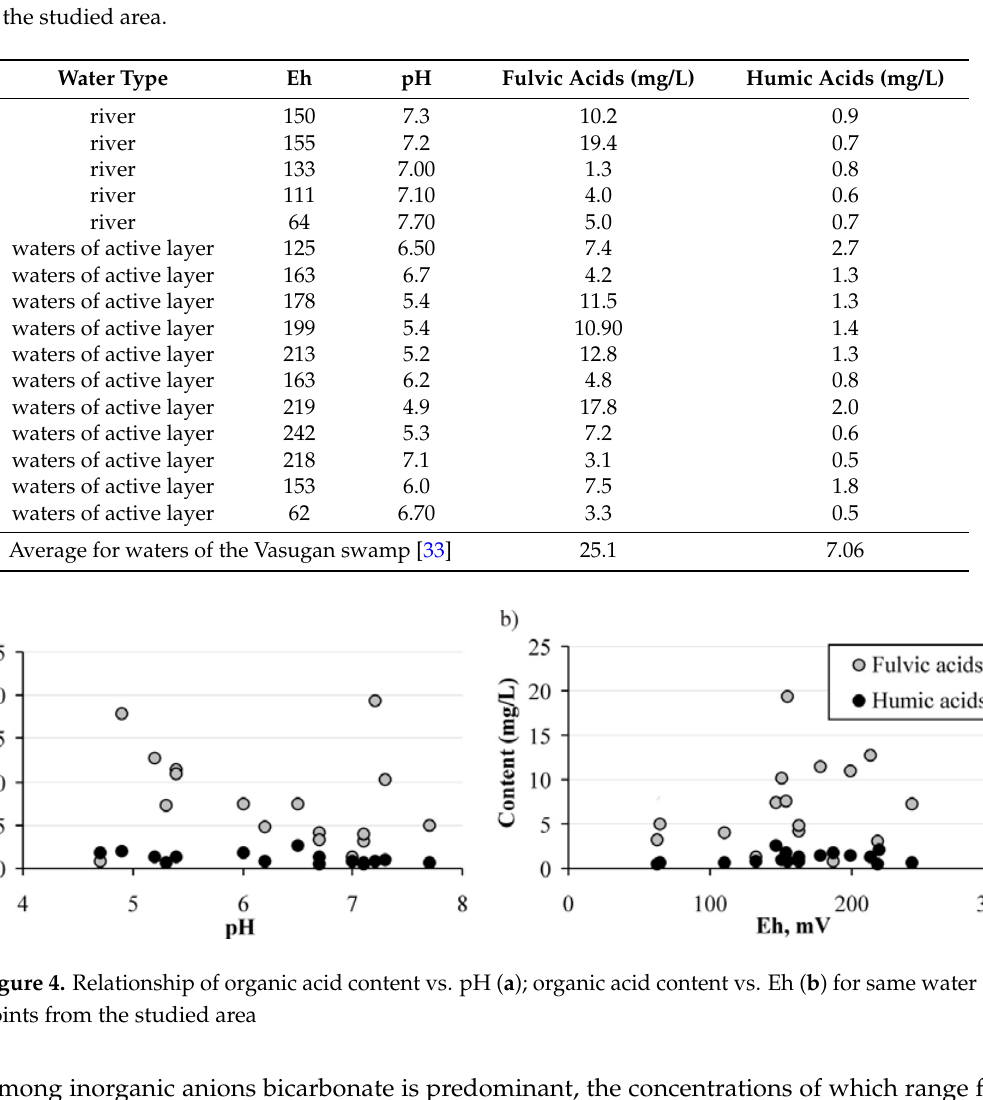
Figure 5. Piper diagram showing anion and cation compositions of the studied waters. 1—waters of active layer; 2—lakes; 3—rivers; 4—waters of stone pits and exploration trenches.